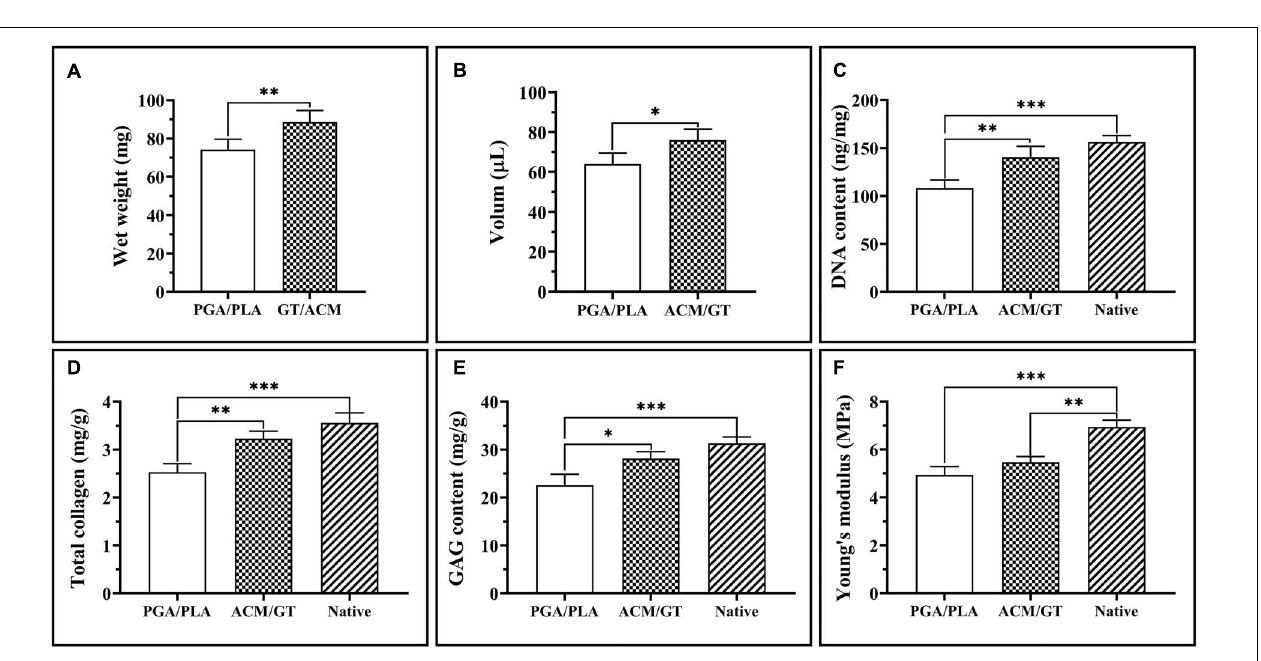
FIGURE 5 | Gross view and histological examination of regenerated cartilage. Gross observation of the cartilage-like tissue regenerated by the cell-PGA/PLA construct (A) and cell-ACM/GT construct (B) which subcutaneously implanted for 8 weeks. Two groups of regenerated cartilage-like tissue were stained with H&E, Safranin-O, and COL II for the assessment of the quality of cartilage formation (C,D) and the quantification of the regenerated cartilage area (%) (E) . Scale bar: 100 µ m. Statistical significance: ∗∗∗ p < 0.001.